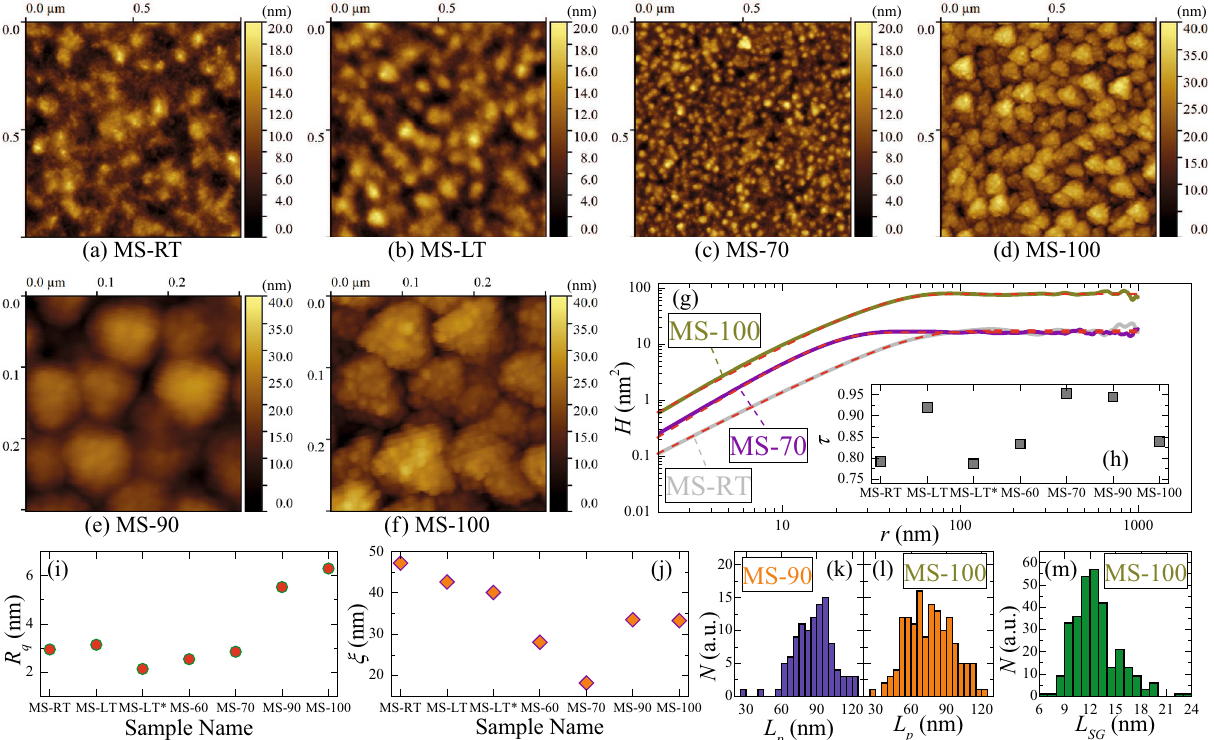
Figure 3. ( a – d ) AFM height images of 1 μm × 1 μm surface region for studied samples. Enlarged AFM height images for samples ( e ) MS-90 and ( f ) MS-100. Presented images were processed using Gwyddion software (ver. 2.58). ( g ) Typical HHCF profiles for studied films in double logarithmic scale. Experimental data was fitted using the Eq.(2), fitting curves are shown as red dashed lines. Derived values of ( h ) scaling exponent, τ , ( i ) RMS roughness, R q , and ( j ) correlation length, ξ , for studied films. Size distribution histogram for polymer globules in samples ( k ) MS-90 and ( l ) MS-100. Provided L p values were calculated as the equivalent disc diameters. (m) Linear size distribution histogram for small grains observed on the surface of polymer globules for sample